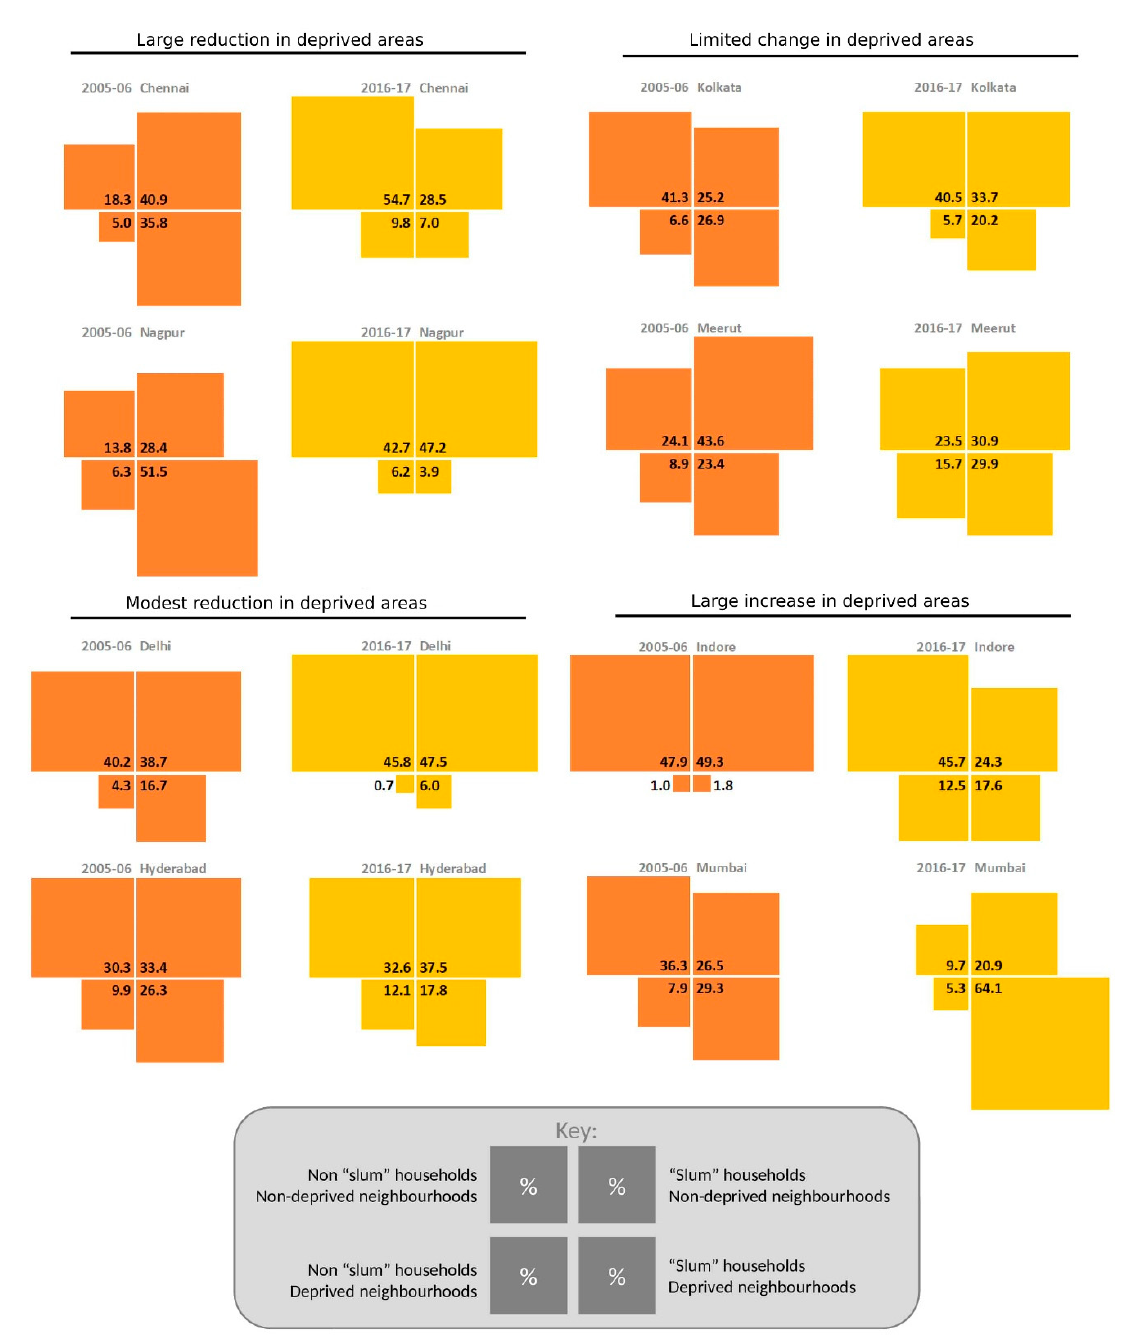
Figure 2. Distribution of population in “slum households” and deprived neighborhoods across eight Indian cities in 2005–2006 and 2016–2017 based on National Family Health Surveys.